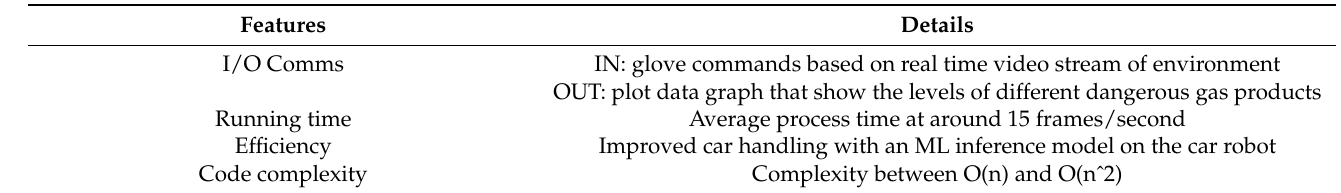
Table 6. The complexity overview for the autonomous robot vehicle architecture.